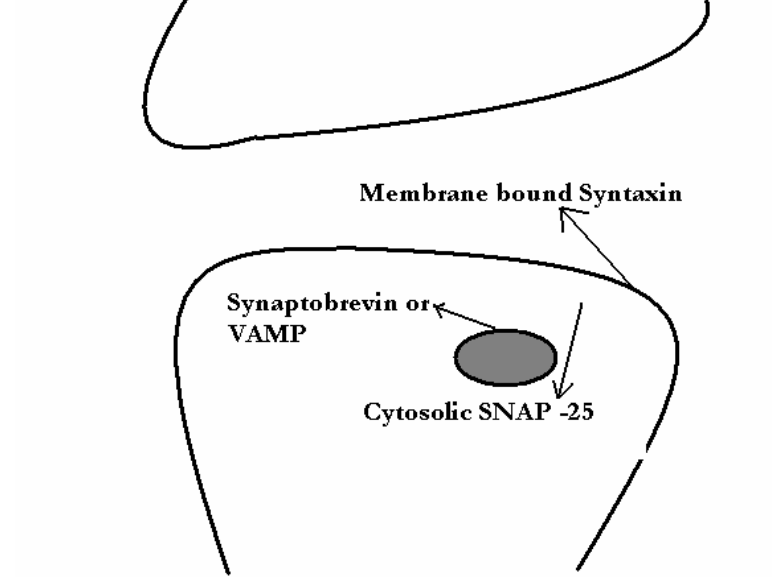
Figure 1: Synaptosomal associated protein receptor (SNARE)